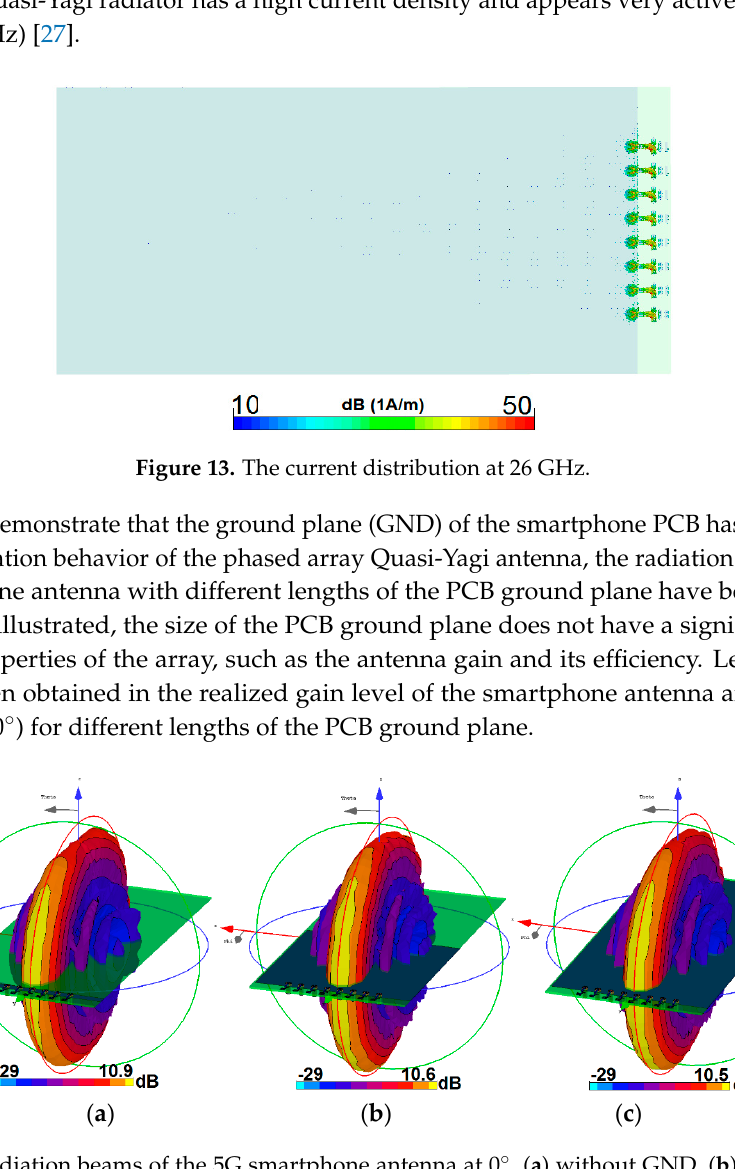
Figure 14. Radiation beams of the 5G smartphone antenna at 0°, ( a ) without GND, ( b ) half, and ( c ) full GND.